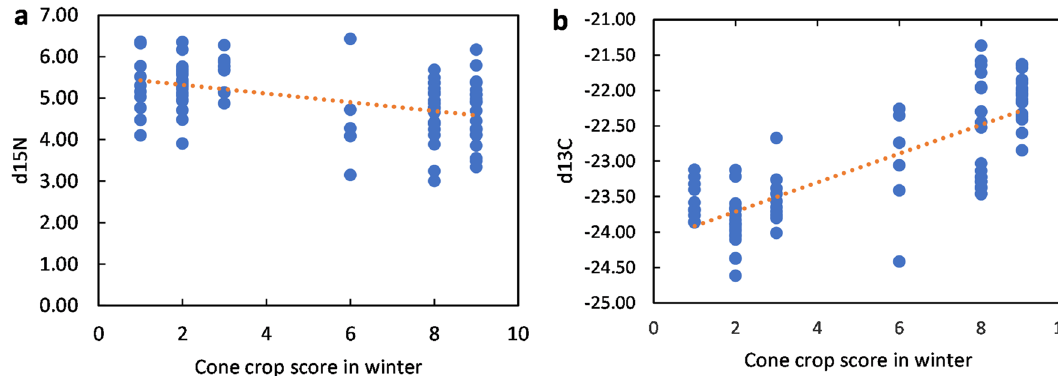
Figure 8. Impact of cone crop on nitrogen and carbon stable isotopes. ( a ) Nitrogen isotope ratio of siskin fledgling feathers in relation to cone score. R 2 = 0.1868. ( b ) Carbon isotope ratio of siskin fledgling feathers in relation to cone score. R 2 =